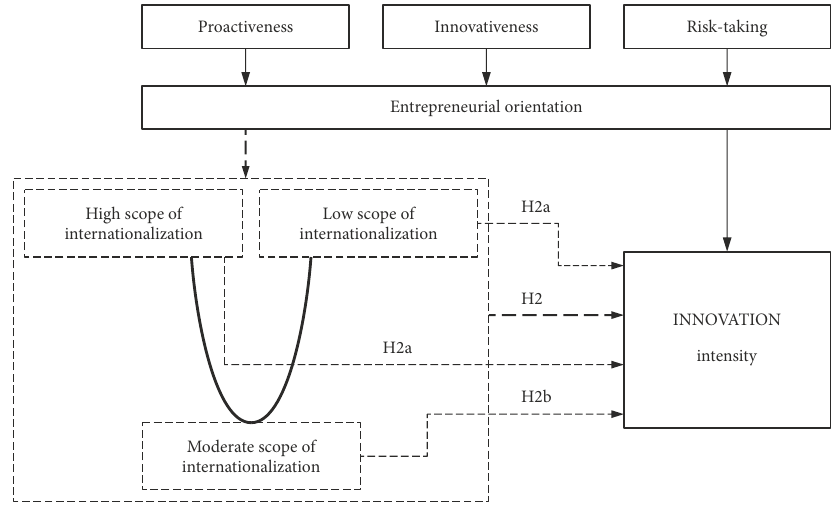
Figure 1. Conceptual model for hypotheses testing (source: own